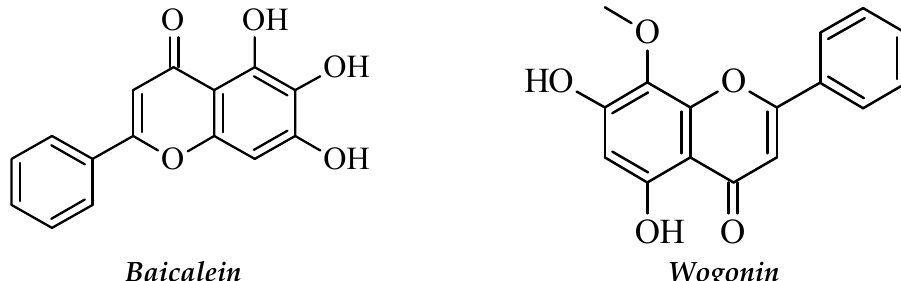
study on wogonoside reported that it is cytotoxic toward HL-60 and U937 cell lines.